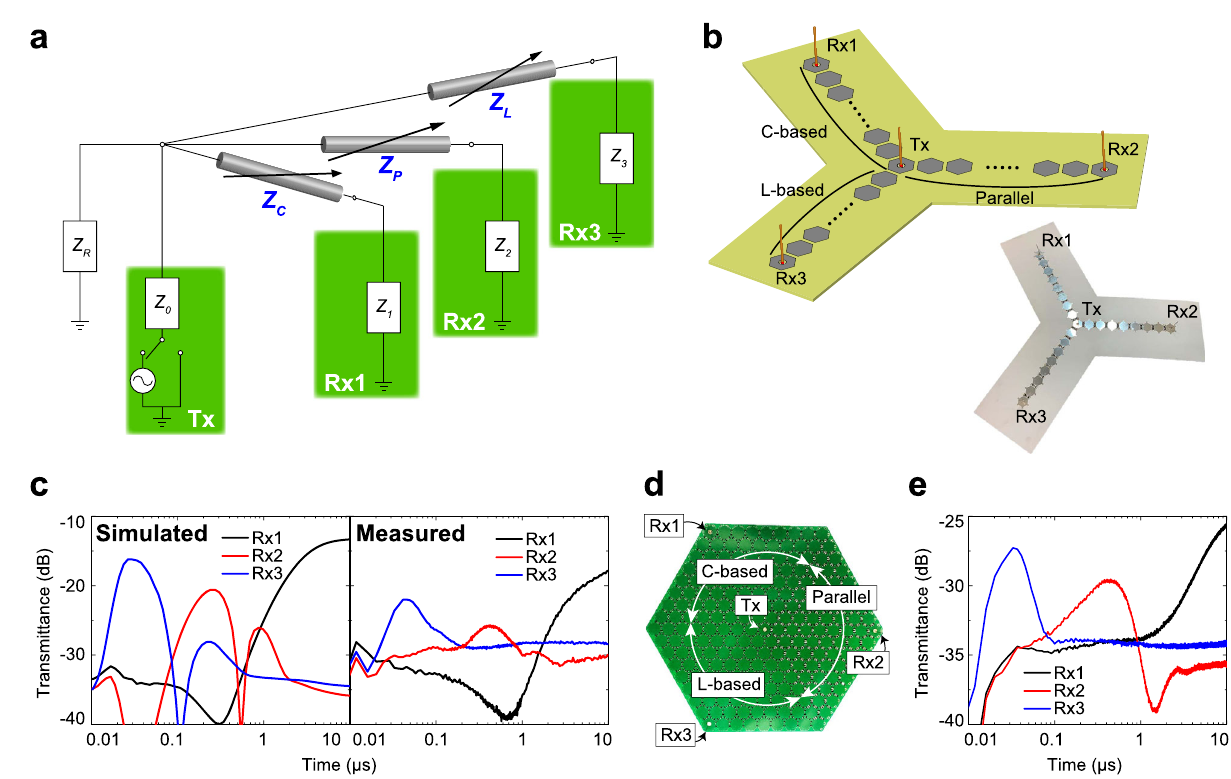
Fig. 2 | Combined selective multiline systems and associated performance. a Extended equivalent circuit concept using additional waveform-selective meta- surfacelinestoselectivelytransmitsignals.Threevariabletransmissionlines Z C , Z L , and Z P represented C-based, L-based and parallel waveform-selective metasurface lines, while Z 1 , Z 2 , and Z 3 were impedances of three receivers Rx1, Rx2, and Rx3. b Monopole transmitter connected by all three types of waveform-selective metasurface lines. c (left) Simulated and (right) measured transmittances to Rx1, Rx2,andRx3.Thefrequencywassetto2.36GHzand2.45GHzinthesimulationand